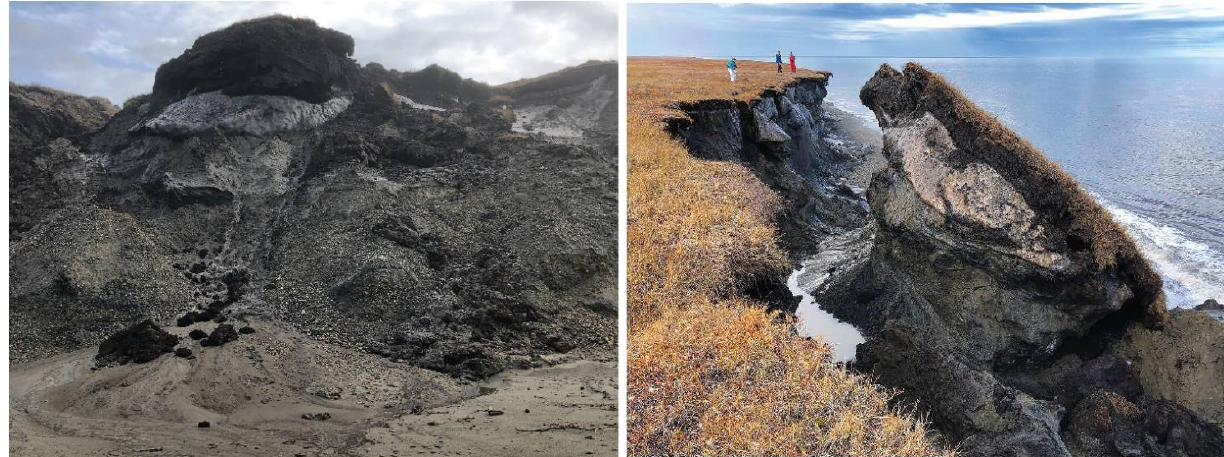
Figure 13. ( left ) Example of thermo-erosional failure processes of dewatering, debris flow, and thaw slumping of the overlying peat layer (2019, photo by A. Gibbs, USGS). ( right ) Large block failure resulting from thermomechanical undercutting of the base of the bluffs (2019, photo by C. Johnson, USGS).